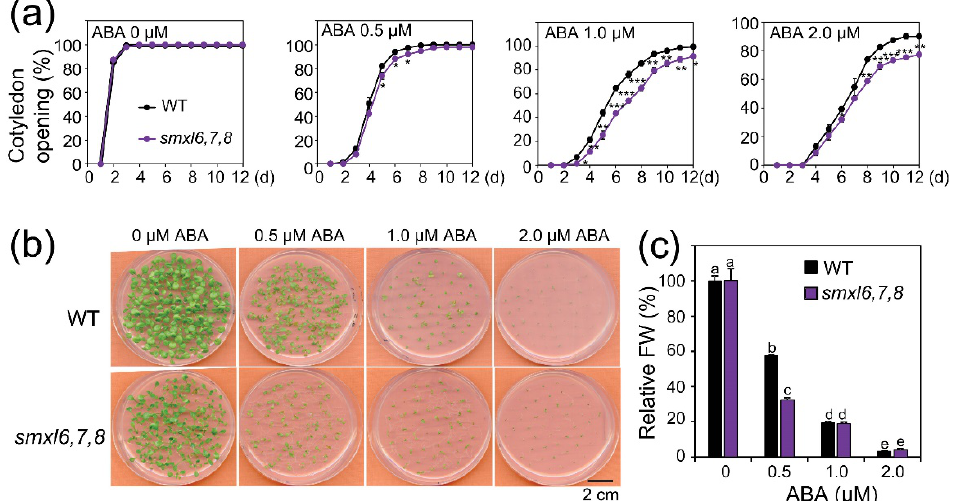
Figure 4. Abscisic acid (ABA) responsiveness of smxl6 , 7 , 8 mutant and wild-type (WT) plants. ( a ) Cotyledon opening of the two genotypes in responses to di ff erent ABA concentrations. Data are means and standard deviations of three independent experiments ( n = 3, 50 seeds / genotype / experiment). Asterisks show significant di ff erence between the smxl6 , 7 , 8 mutant and WT plants at each time point (Student’s t -test; * p < 0.05, ** p < 0.01 and *** p < 0.001). ( b ) Growth of the two genotypes on medium supplied with di ff erent ABA concentrations. Representative pictures of 14-day-old plants are shown. ( c ) Relative fresh weights (FW) of 14-day-old smxl6 , 7 , 8 mutant and WT seedlings grown on medium supplied with di ff erent ABA concentrations. Data show means and standard errors ( n = 5 replicates, six seedlings / replicate). Letters above the error bars show significant di ff erences in all combinations (Tukey’s honest significant di ff erence test; p < 0.05).